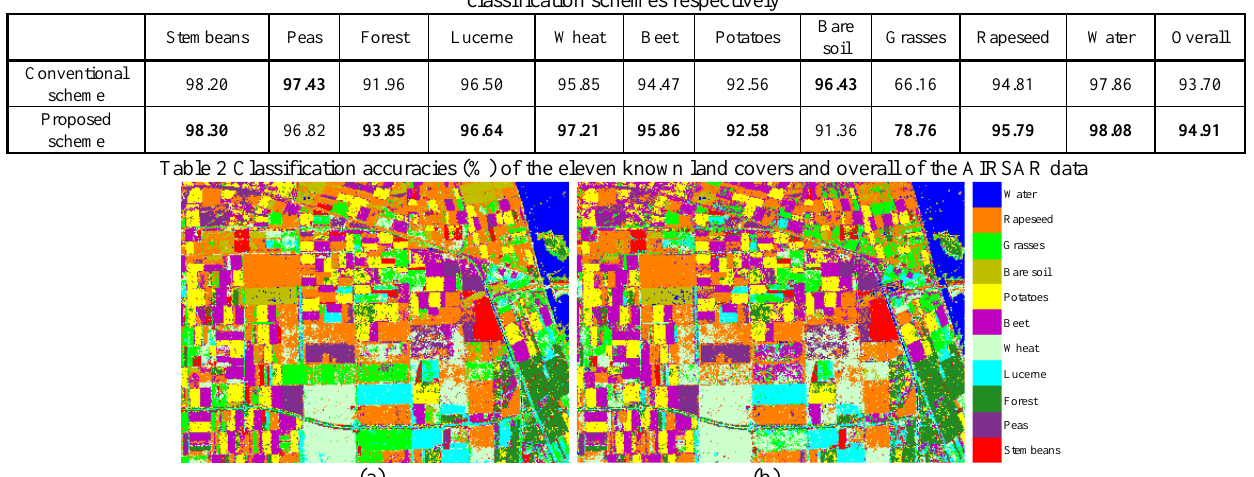
Figure 3 Classification results over the area with eleven known land covers. (a) and (b) are with the conventional and proposed